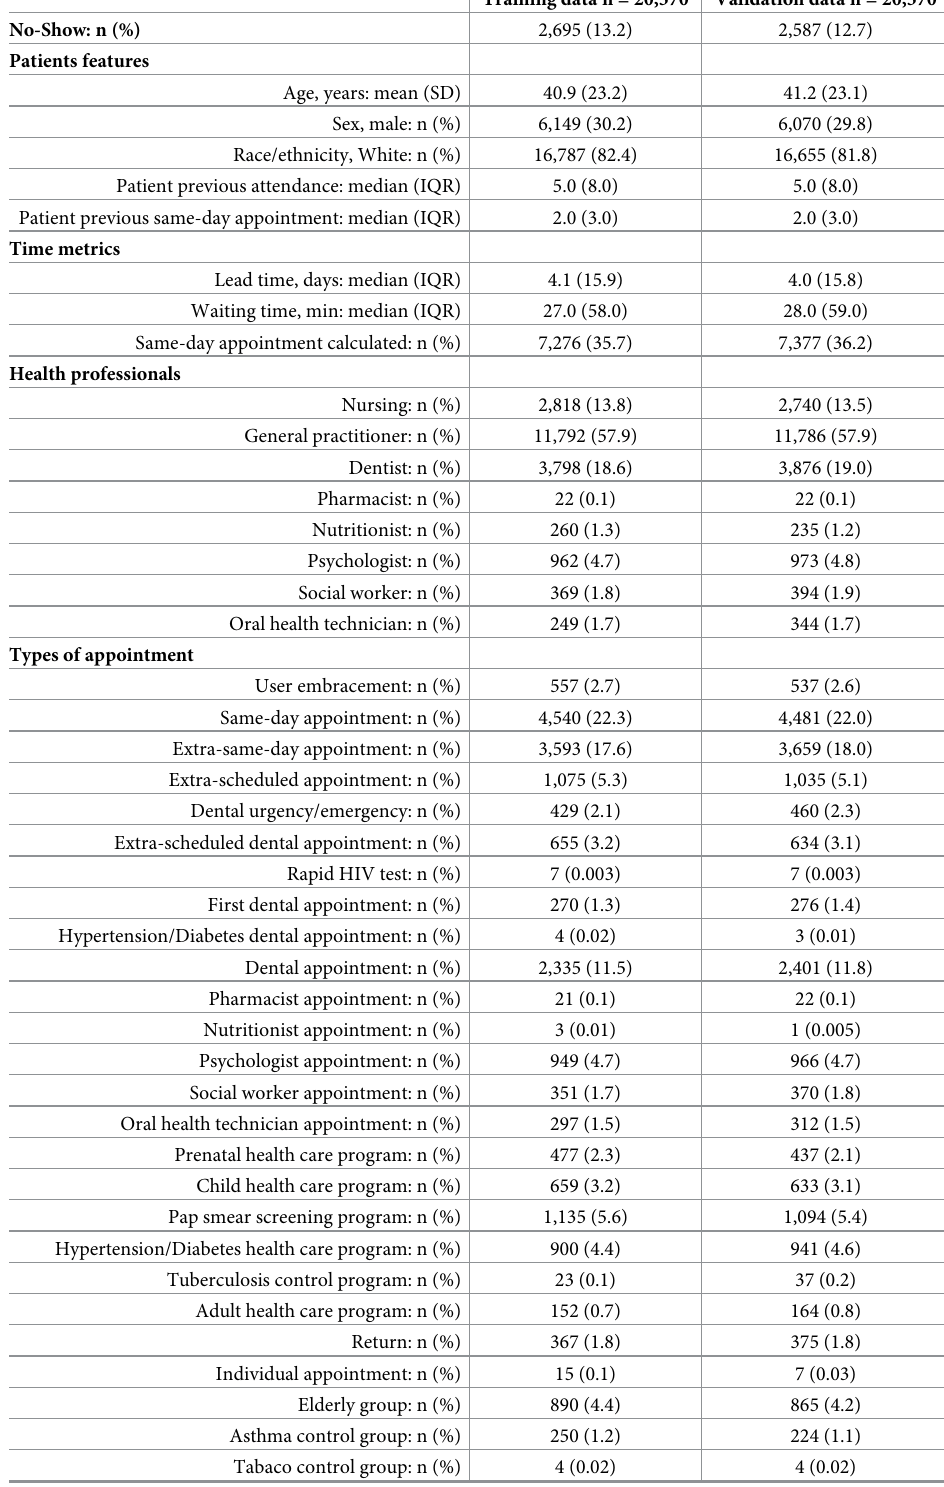
Table 3. Comparison between development and validation